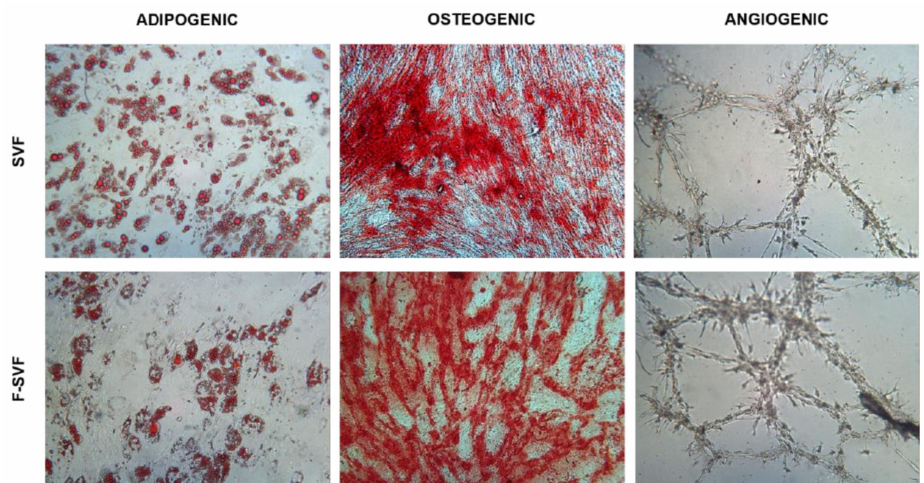
Figure 6. Plasticity of stromal vascular fraction (SVF) and the fraction derived stromal vascular fraction (F-SVF) cells was investigated by differentiation ability towards adipogenic, osteogenic, and angiogenic lineages. Cells from both conditions developed the characteristic lipid vacuoles (stained by Oil Red O), produced extracellular matrices (stained by Alizarin Red S), and rearranged to form tubes, as shown in the new vessel formation assay (images obtained using a 10 ×